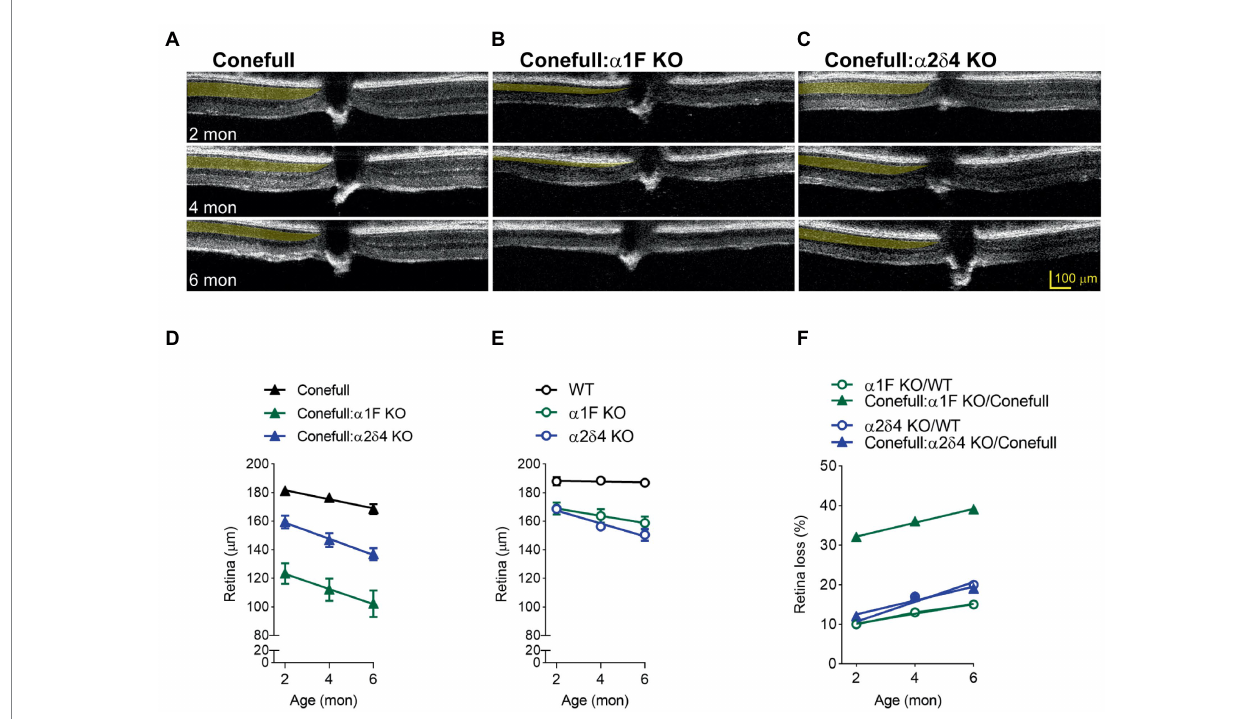
FIGURE 4 Retinal degeneration is severe in Conefull: α 1F KO. Representative OCT images of (A) Conefull, (B) Conefull: α 1F KO, or (C) Conefull: α 2 δ 4 KO with the photoreceptor layer to the left of the optic nerve highlighted in yellow at 2, 4, or 6 months of age. (D) Retinal thickness from 2 to 6 months for Conefull (black), Conefull: α 1F KO (green), or Conefull: α 2 δ 4 KO (blue). (E) Retina thickness from 2 to 6 months for wildtype, α 1F KO (green), or α 2 δ 4 KO (blue). (F) Retinal loss normalized to strain background. Degeneration due to α 1F KO (green) is more severe in the Conefull background whereas degeneration in α 2 δ 4 KO (blue) is not.